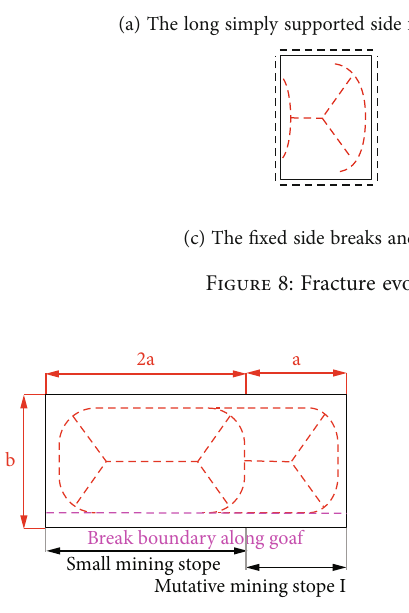
Figure 9: Prolonged “ O-X ” fracture of subsequent small mining stope.